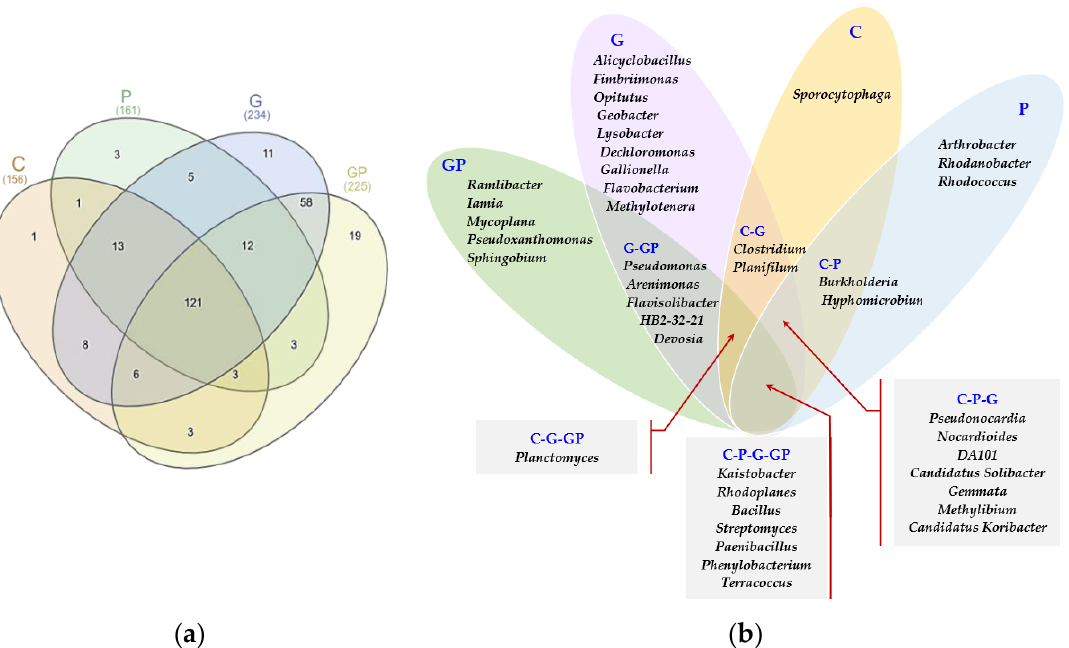
Figure 5. Effect of petrol (P) and cocksfoot (G) on ( a ) the number of unique and common bacterial genera, ( b ) unique and common genera of bacteria colonizing particular pots presented using the Veen diagram. C — non-polluted and non-sown soil, G — non-polluted soil sown with cocksfoot, P — non-sown soil polluted with petrol, and GP — soil polluted with petrol and sown with cocksfoot.